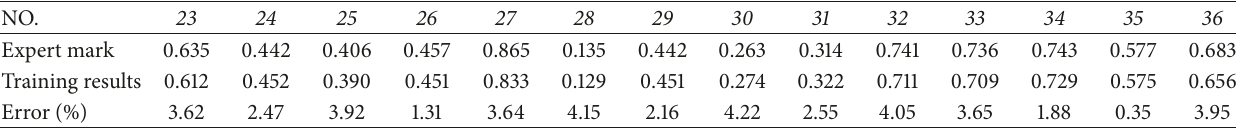
Table 6: Validation results of BP neural network on construction risk of railways in 14 Asian countries.